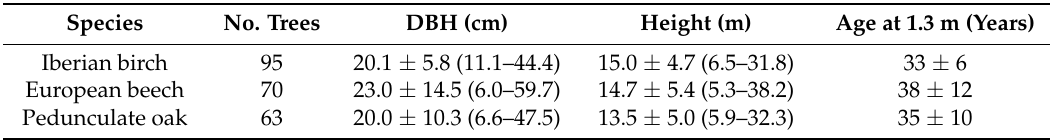
Table 1. Number of sampled trees, diameter at breast height (DBH), height and age. Values are the mean ± standard deviation (with the range indicated between parentheses).